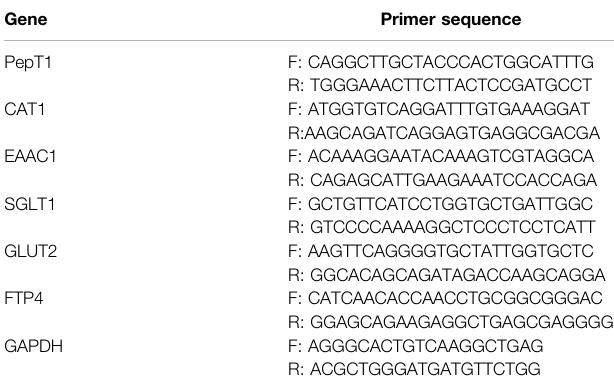
TABLE 2 | Primers for real-time